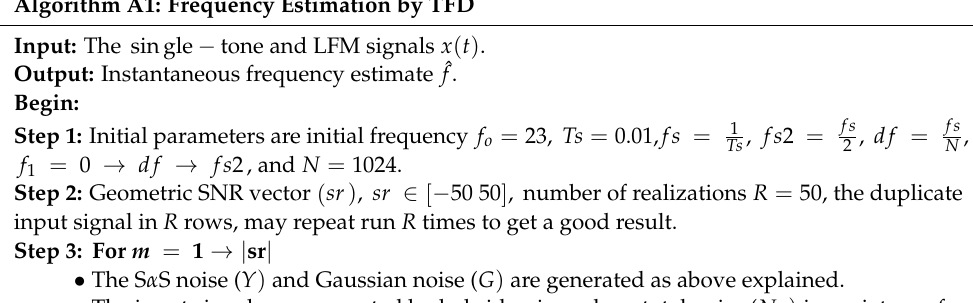
Algorithm A1: Frequency Estimation by